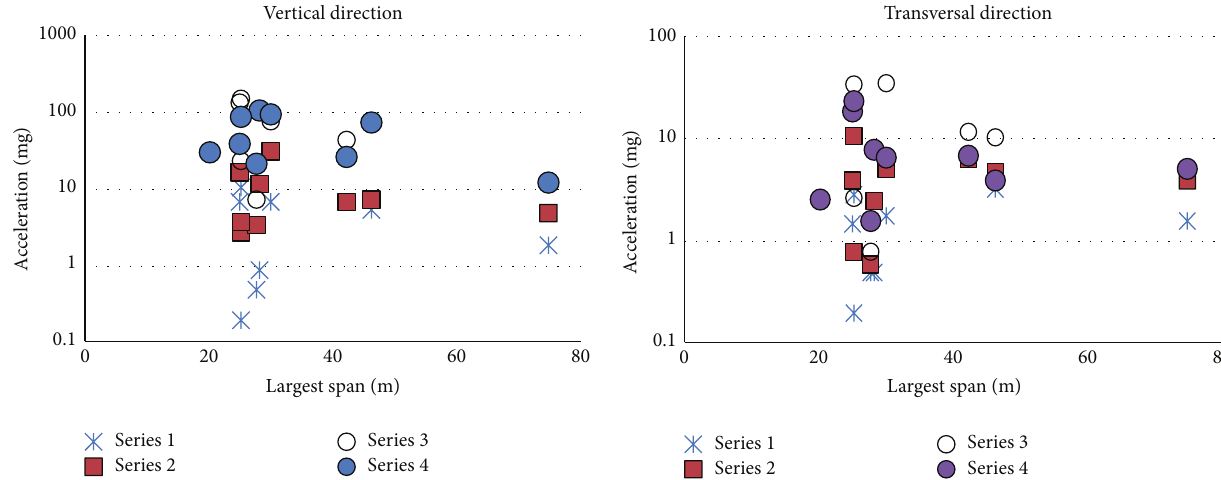
Figure 8: Amplitude values in mg of the measured maximum motion at mid-span. Series 1: noise; Series 2: 1 person walking at “normal” pace (2Hz); Series 3: 1 person jumping from 30 cm; Series 4: excitation close to resonant conditions.